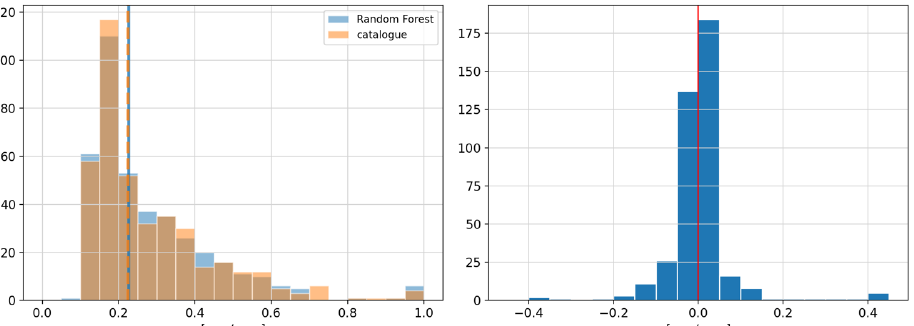
Figure 16. Estimated station coordinate velocity uncertainties. ( Left ): absolute uncertainty values based on the proposed machine learning based discontinuity classification results (blue) and the NGL discontinuity database (orange). The blue and dashed orange line mark the corresponding median values. ( Right ): difference between estimated machine learning and NGL station coordinate velocity